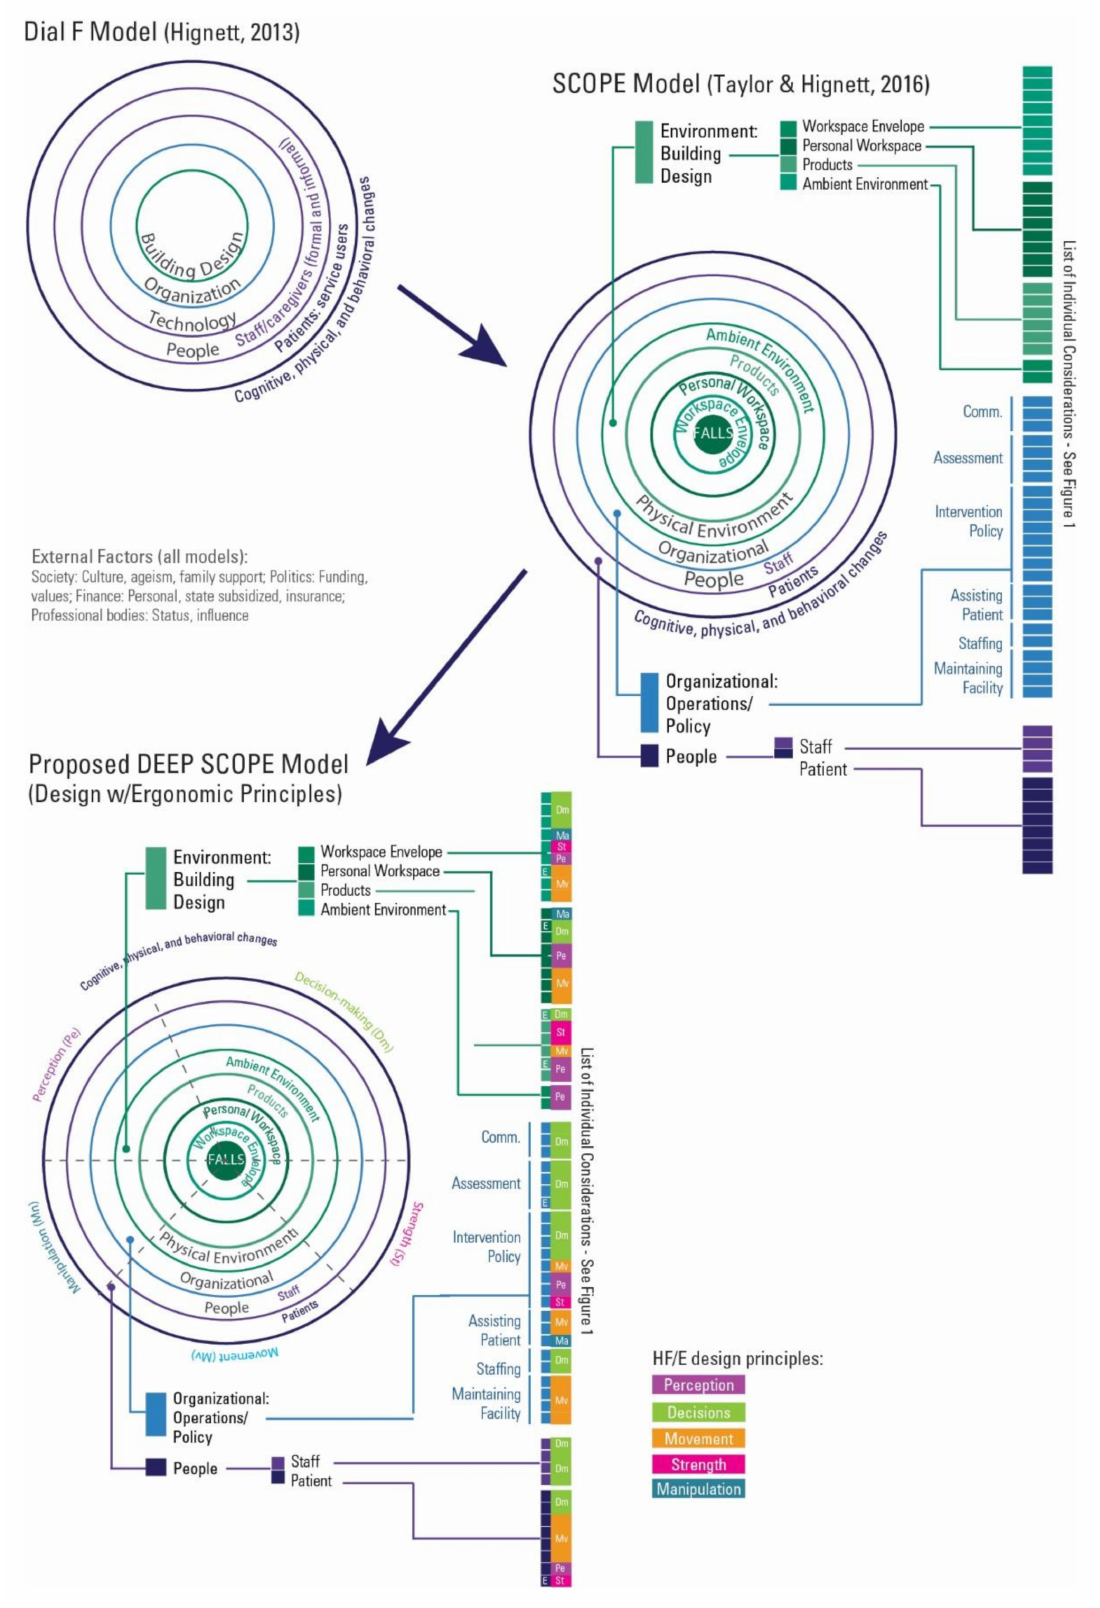
Figure 2. The evolution of the SCOPE and DEEP SCOPE